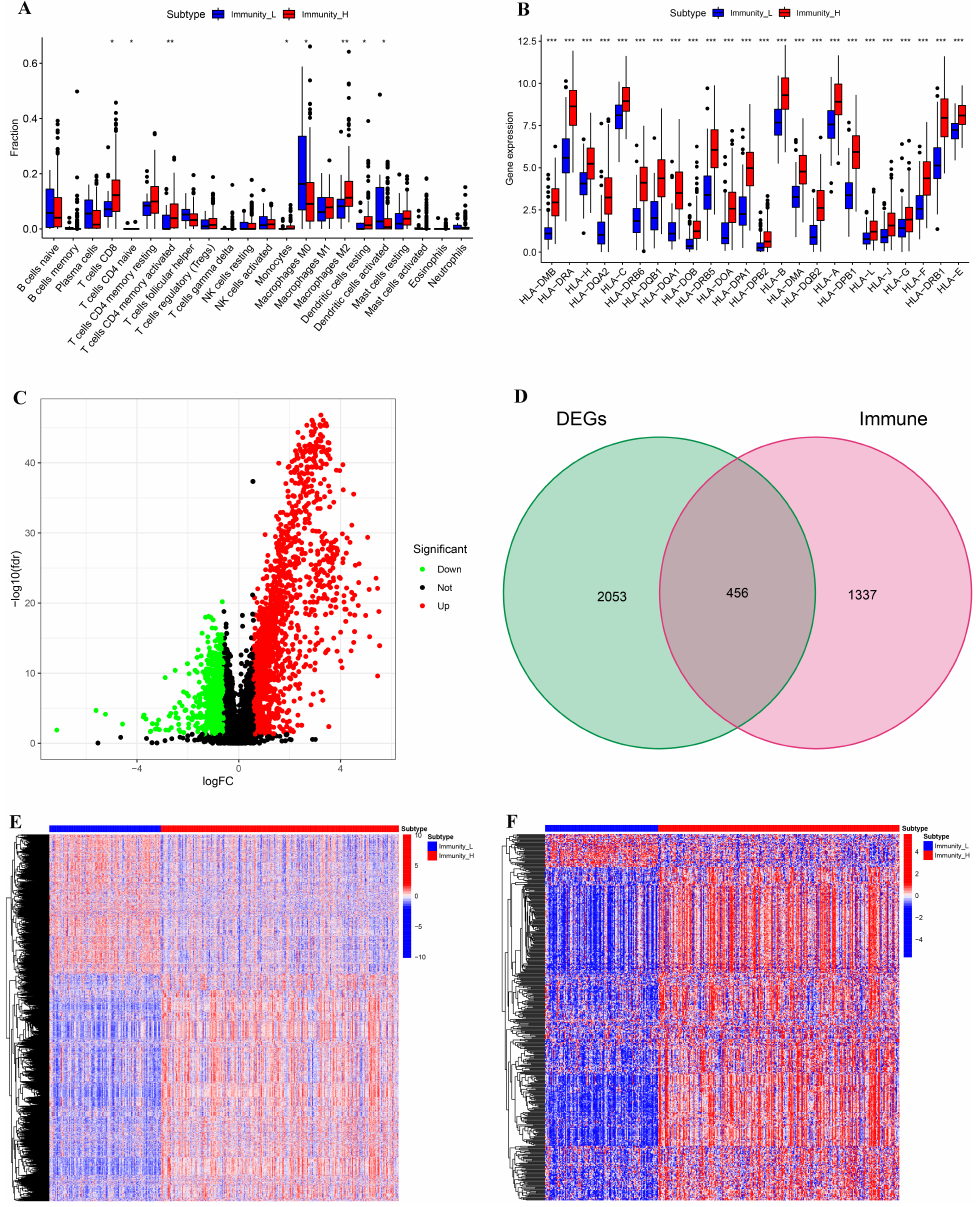
Figure 2. Comparative analyses of immune-cell infiltration, HLA gene expression, DEGs, and DEIGs in the two subtypes. ( A ) Comparison of the immune-cell infiltration between Immunity_H and Immunity_L. ( B ) Comparison of the expression levels of HLA genes between two subtypes. ( C ) Volcano plot of DEGs (Immunity_H vs. Immunity_L); |LogFC| >0.585 and FDR <0.05. ( D )